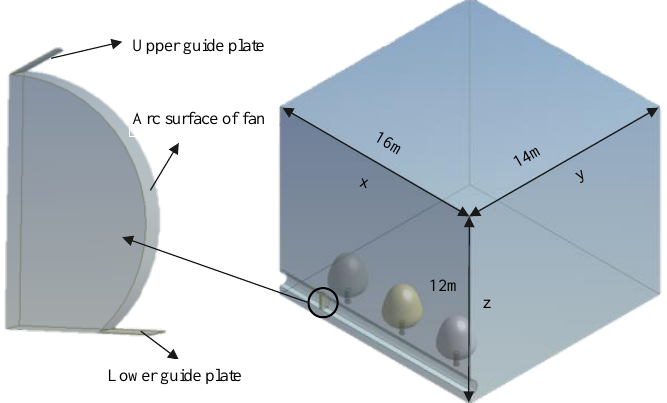
Figure 4. Schematic diagram of fluid calculation area.